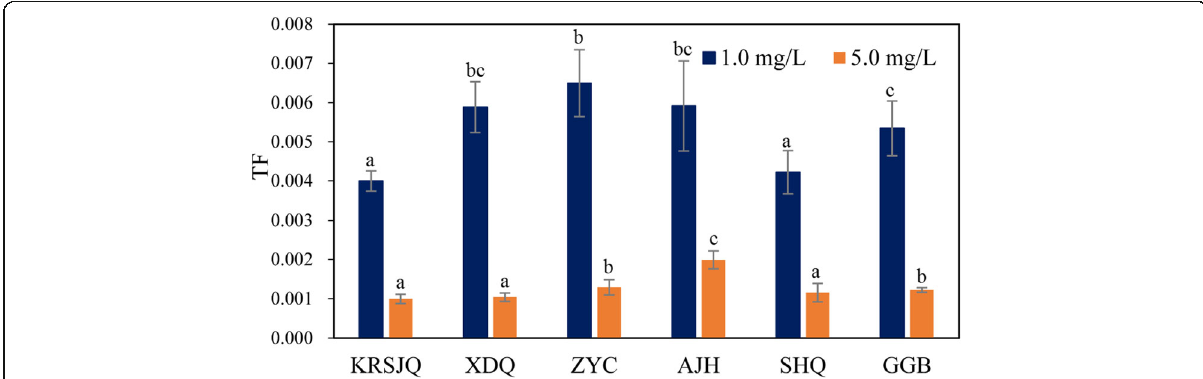
Fig. 2 The translocation factor (TF) for six vegetables (Kangresijiqing (KRSJQ), Xiadiqing (XDQ), Ziyoucai (ZYC), Aijiaohuang (AJH), Shanghaiqing (SHQ) and Gaogengbai (GGB)) in 1.0 mg/L and 5.0 mg/L treatments. Each treatment consisted of five replicates. The bars with the different letter(s) were significantly different ( p <